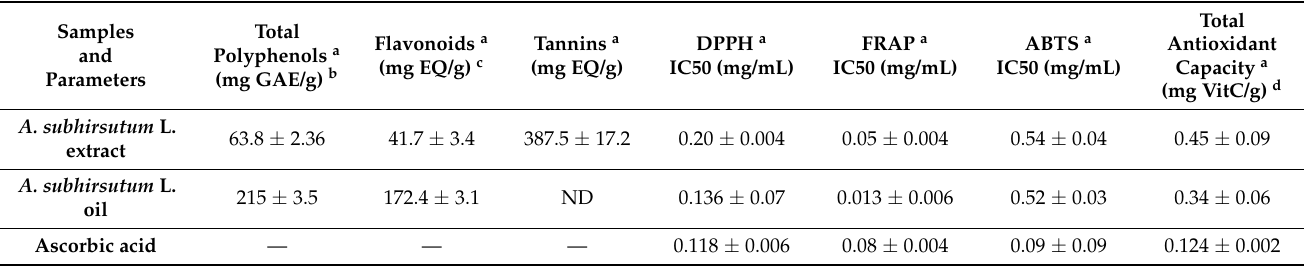
Table 1. Amounts of total phenolic components, flavonoids, tannins and IC50 for the DPPH scavenging activity, ferric reducing antioxidant power (FRAP), ABTS antioxidant activity and total antioxidant capacities (TAC) of Allium subhirsutum L. extract and oil. Ascorbic acid was used as